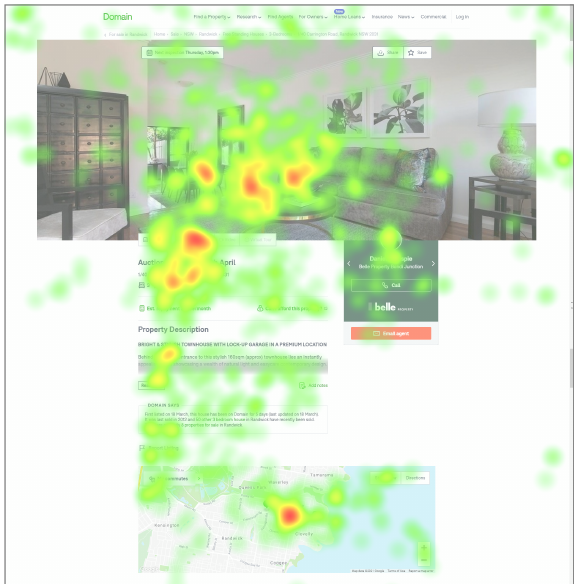
Figure 2. Heat-map showing the cumulative fixations on a property listing across all the trails.